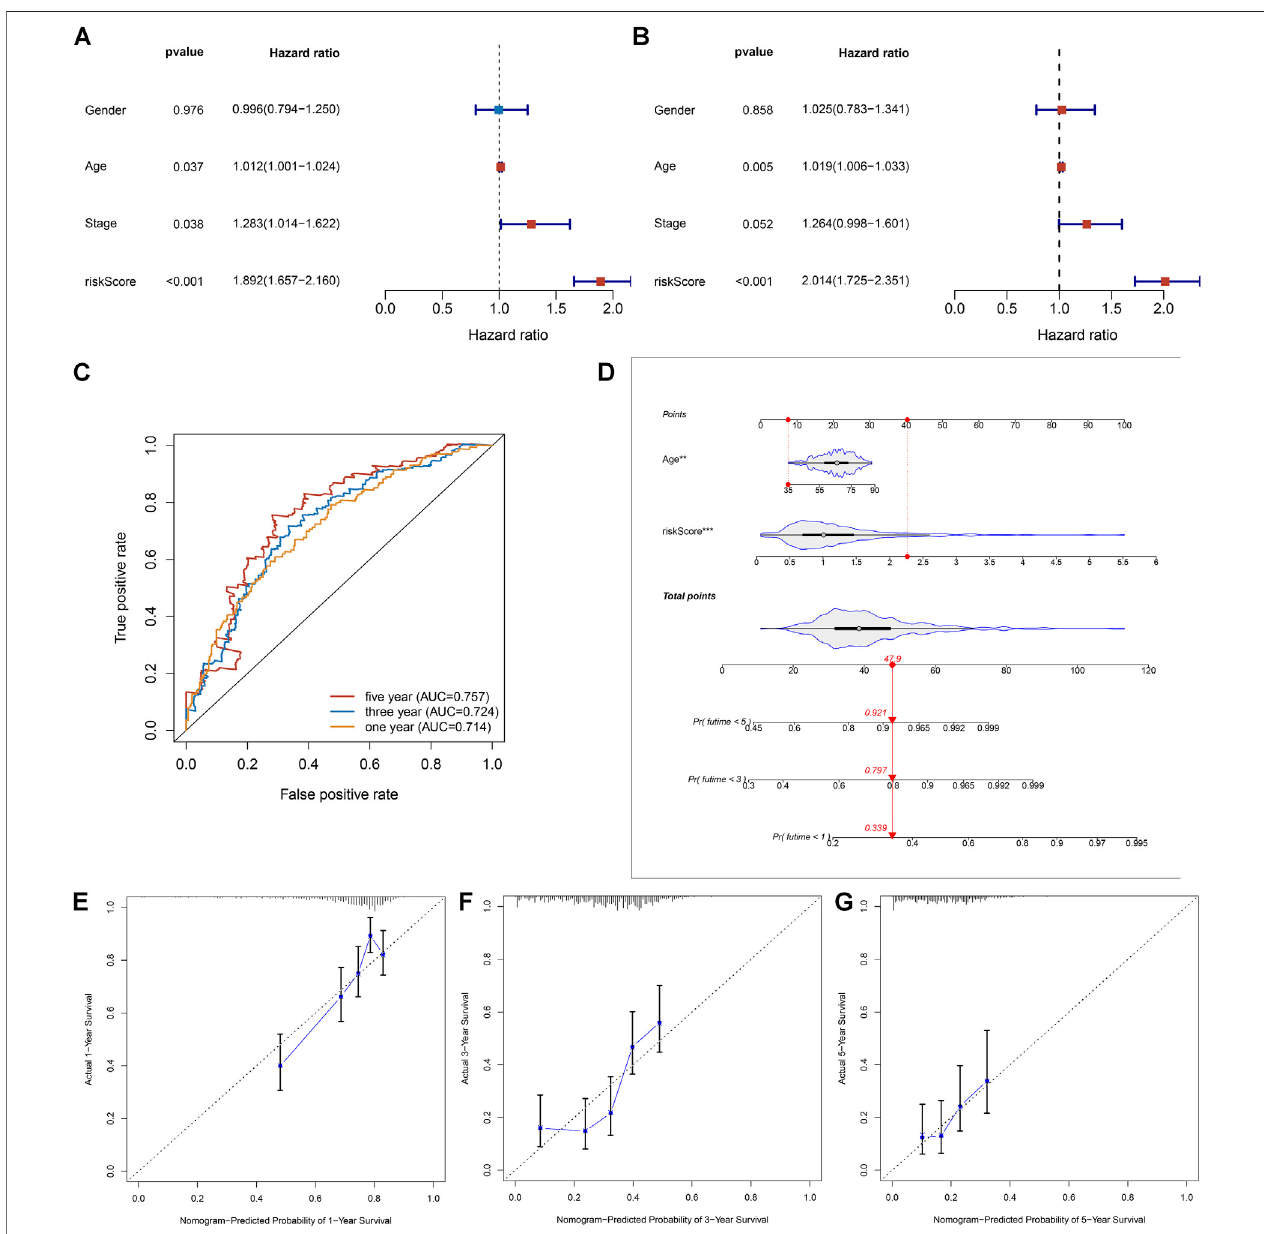
FIGURE5| Necroptosis-relevantriskmodelasareliableandindependentprognosticindicatorofpancreaticcancer. (A,B) Forestplotsshowthecorrelationsofthe necroptosis-relevantrisk score,age, and stage withpancreatic cancerprognosisthrough (A) uni- and (B) multivariate Coxregressionmodels. (C) ROCcurves at 1-, 3-, and 5-year survival for the necroptosis-relevant risk score. (D) Generation of an age- and risk score – based prognostic nomogram. (E – G) Calibration curves depict the deviations between nomogram-predicted probabilities of 1-, 3-, and 5-year survival and actual survival outcomes.